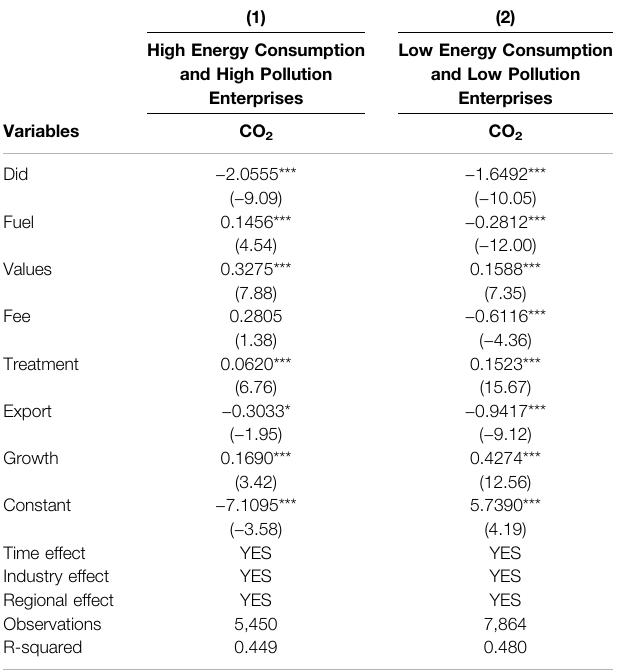
TABLE 5 | Heterogeneity